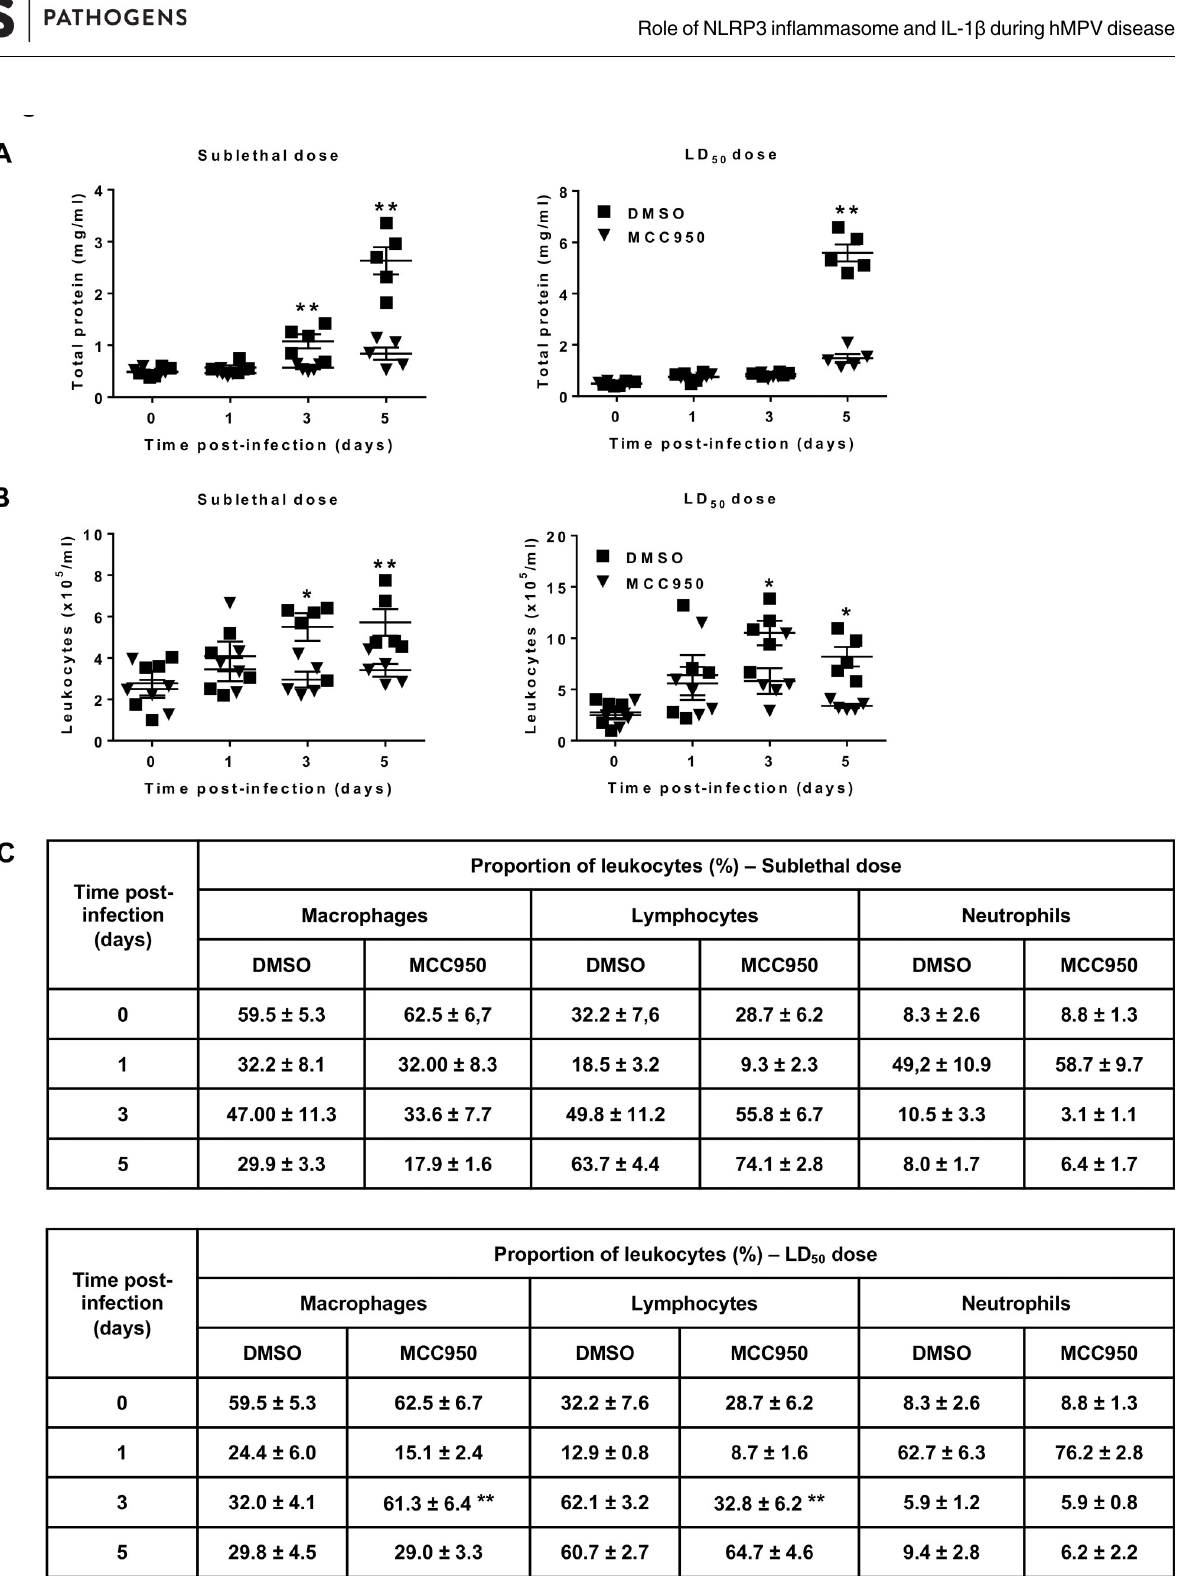
PLOS Pathogens| https://doi.org/10.1371/journal.ppat.1007689 April 9,